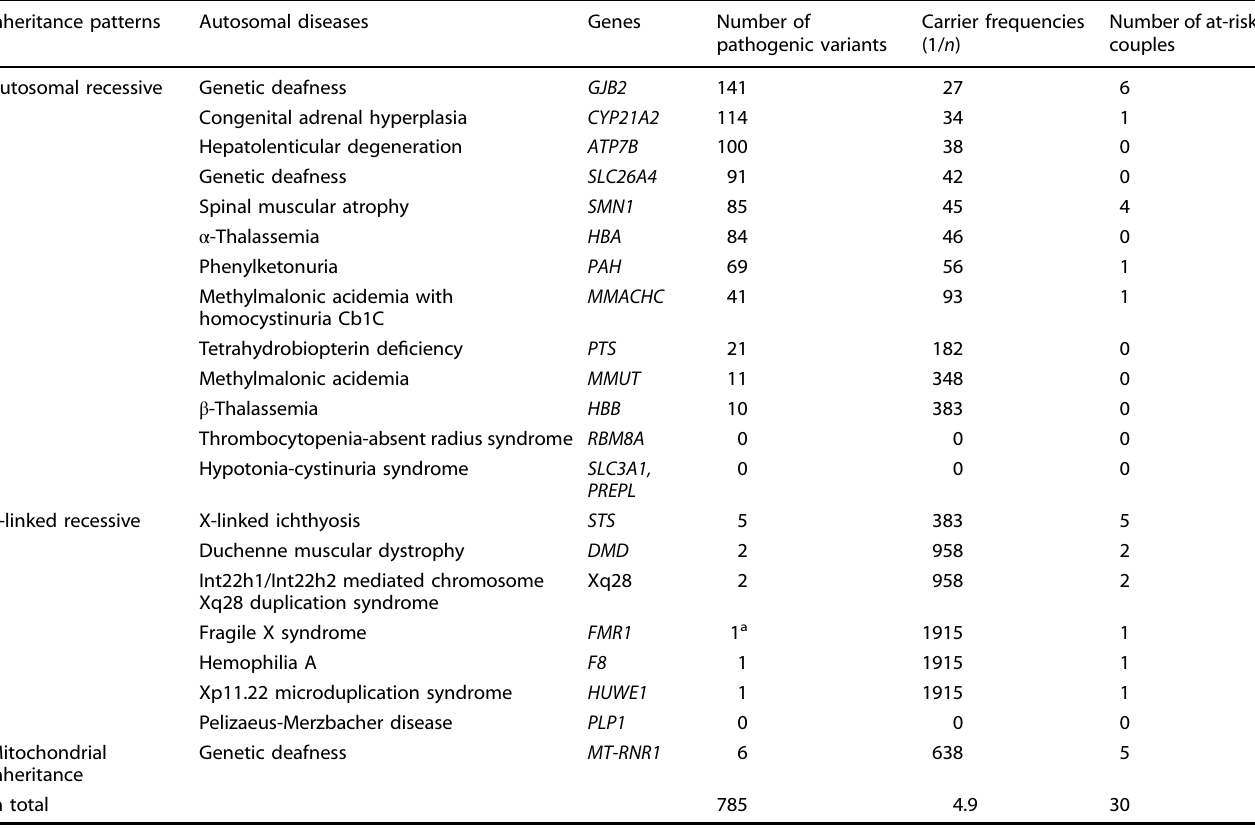
Table 2. Carrier frequencies for autosomal diseases in 1915 couples (3830